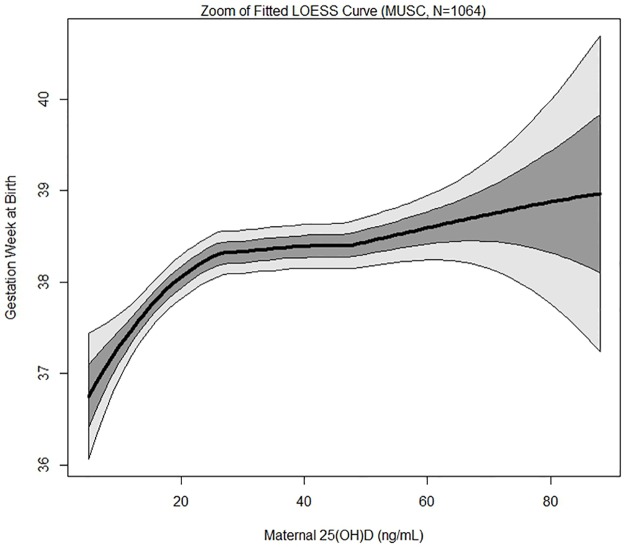
Zoom of the fitted LOESS curve of maternal 25(OH)D concentration and gestational age (weeks) at birth with 1 and 2 SD windows superimposed.Black line represents fitted LOESS curve, dark gray area represents 1 standard deviation, and light gray area represents 2 standard deviations.